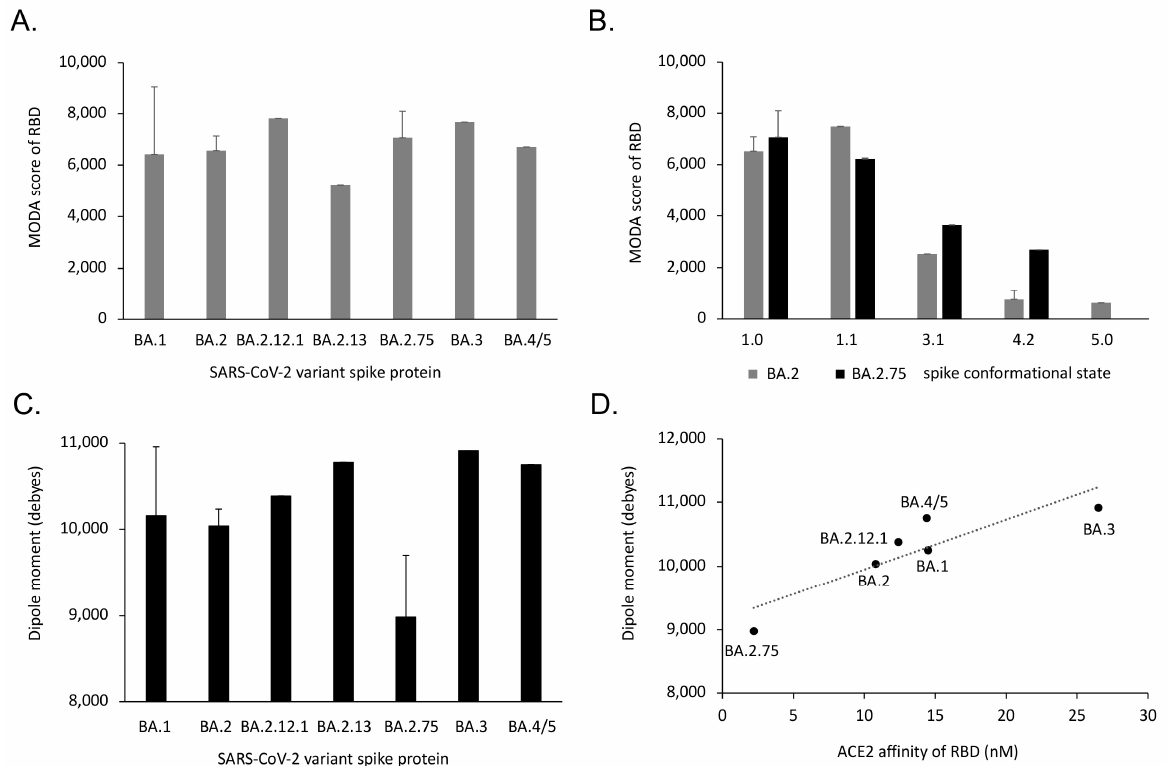
Figure 5. Membrane binding by conformational states of SARS-CoV-2 Omicron variants. ( A ) The average membrane binding propensities of the RBD subunit of the closed spike trimer structures are shown for each of the variants. ( B ) The average membrane binding propensities of the subunits of the closed, open, singly, doubly, and triply ACE-2-bound forms (states 1.0, 1.1, 3.2, 4.2, and 5, Figure 1) are shown for spike trimer structures (Table 2) of the Omicron BA.2 and BA.2.75 subvariants and ( C ) dipole moments of the closed structures of the Omicron subvariant spike ectodomain trimers, with standard deviations shown unless there are insufficient numbers of structures to calculate this. ( D ) The average dipole moments of the closed structures of the Omicron variant spike ectodomain trimers are linearly correlated with the ACE-2 binding affinities of their RBD domains